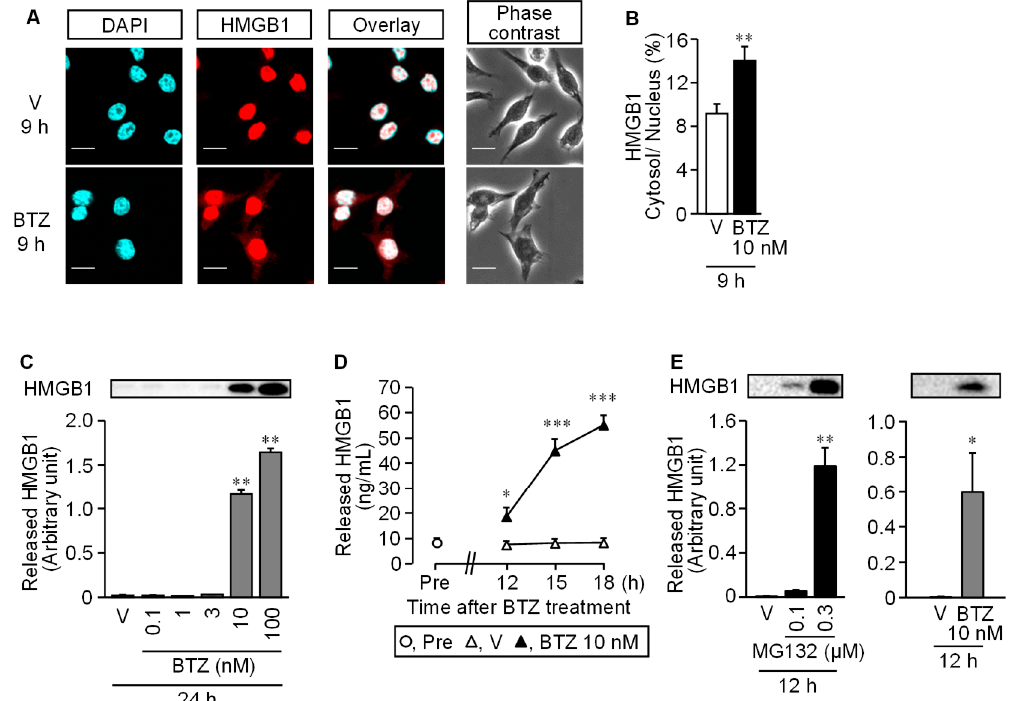
Figure 6. Cytoplasmic translocation and extracellular release of nuclear HMGB1 in RAW264.7 macrophages stimulated with bortezomib. ( A , B ) Translocation of HMGB1 from the nucleus to the cytoplasm in RAW264.7 cells. The cells were stimulated with bortezomib at 10 nM for 9 h, and HMGB1 was detected by immunofluorescence staining. Blue, DAPI (nucleus); red, HMGB1; Scale bar, 50 µ m ( A ). ( B ) Proportion (%) of fluorescence signal of HMGB1 in the cytoplasm to that in the nucleus. ( C ) Extracellular release of HMGB1 from RAW264.7 cells stimulated with bortezomib at 0.1–100 nM for 24 h, as assessed by Western blotting. Typical photographs are shown on the top above columns. ( D ) Time-dependent HMGB1 release from RAW264.7 cells stimulated with bortezomib at 10 nM for 12, 15, or 18 h, as assessed by ELISA. ( E ) MG132, another well-known proteasome inhibitor, as well as bortezomib causes HMGB1 release from RAW264.7 cells. The cells were stimulated with MG132 at 0.1 or 0.3 µ M or bortezomib at 10 nM for 12 h, and the extracellular HMGB1 was determined by Western blotting. Typical photographs are shown on the top above columns. Data show the mean with S.E.M for 5 different experiments ( B , C , D , E ). V, vehicle; BTZ, bortezomib. * p < 0.05, ** p < 0.01, *** p < 0.001 vs. V.